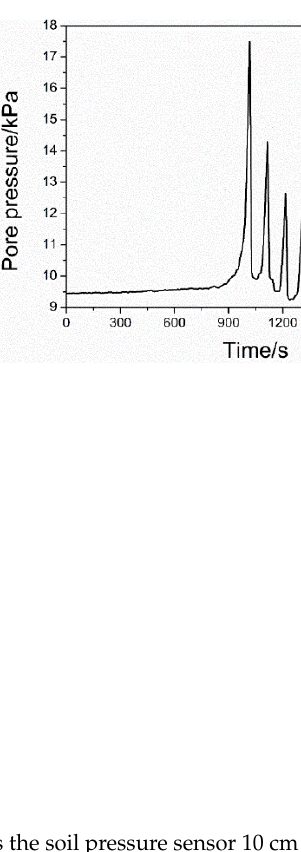
Figure 19. Lateral soil pressure. Note: M-10 denotes the soil pressure sensor 10 cm from the end, and M-40 denotes the sensor 40 cm from the end.